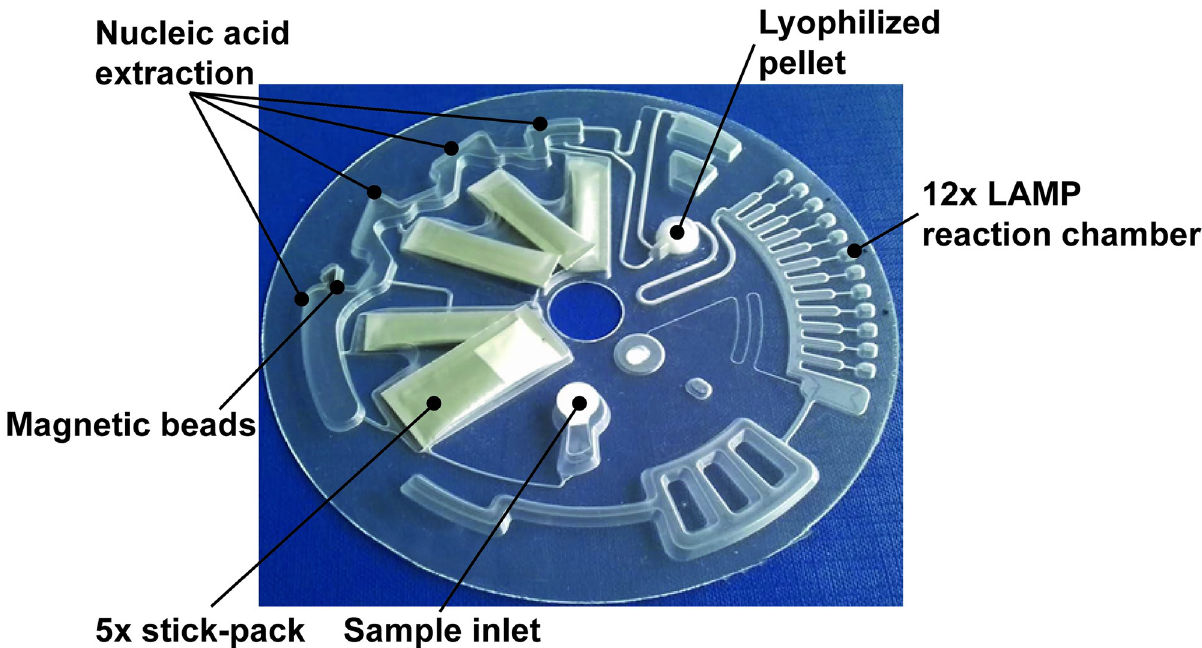
Fig 1. Photograph of a FeverDisk cartridge. All reagents are pre-stored for fully automated nucleic acid analysis. The sample inlet is sealed with a pre- mounted sealing foil.